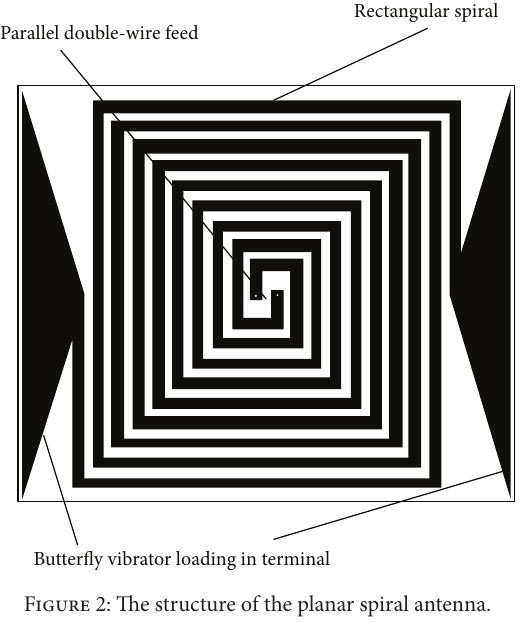
Figure 2: The structure of the planar spiral antenna.